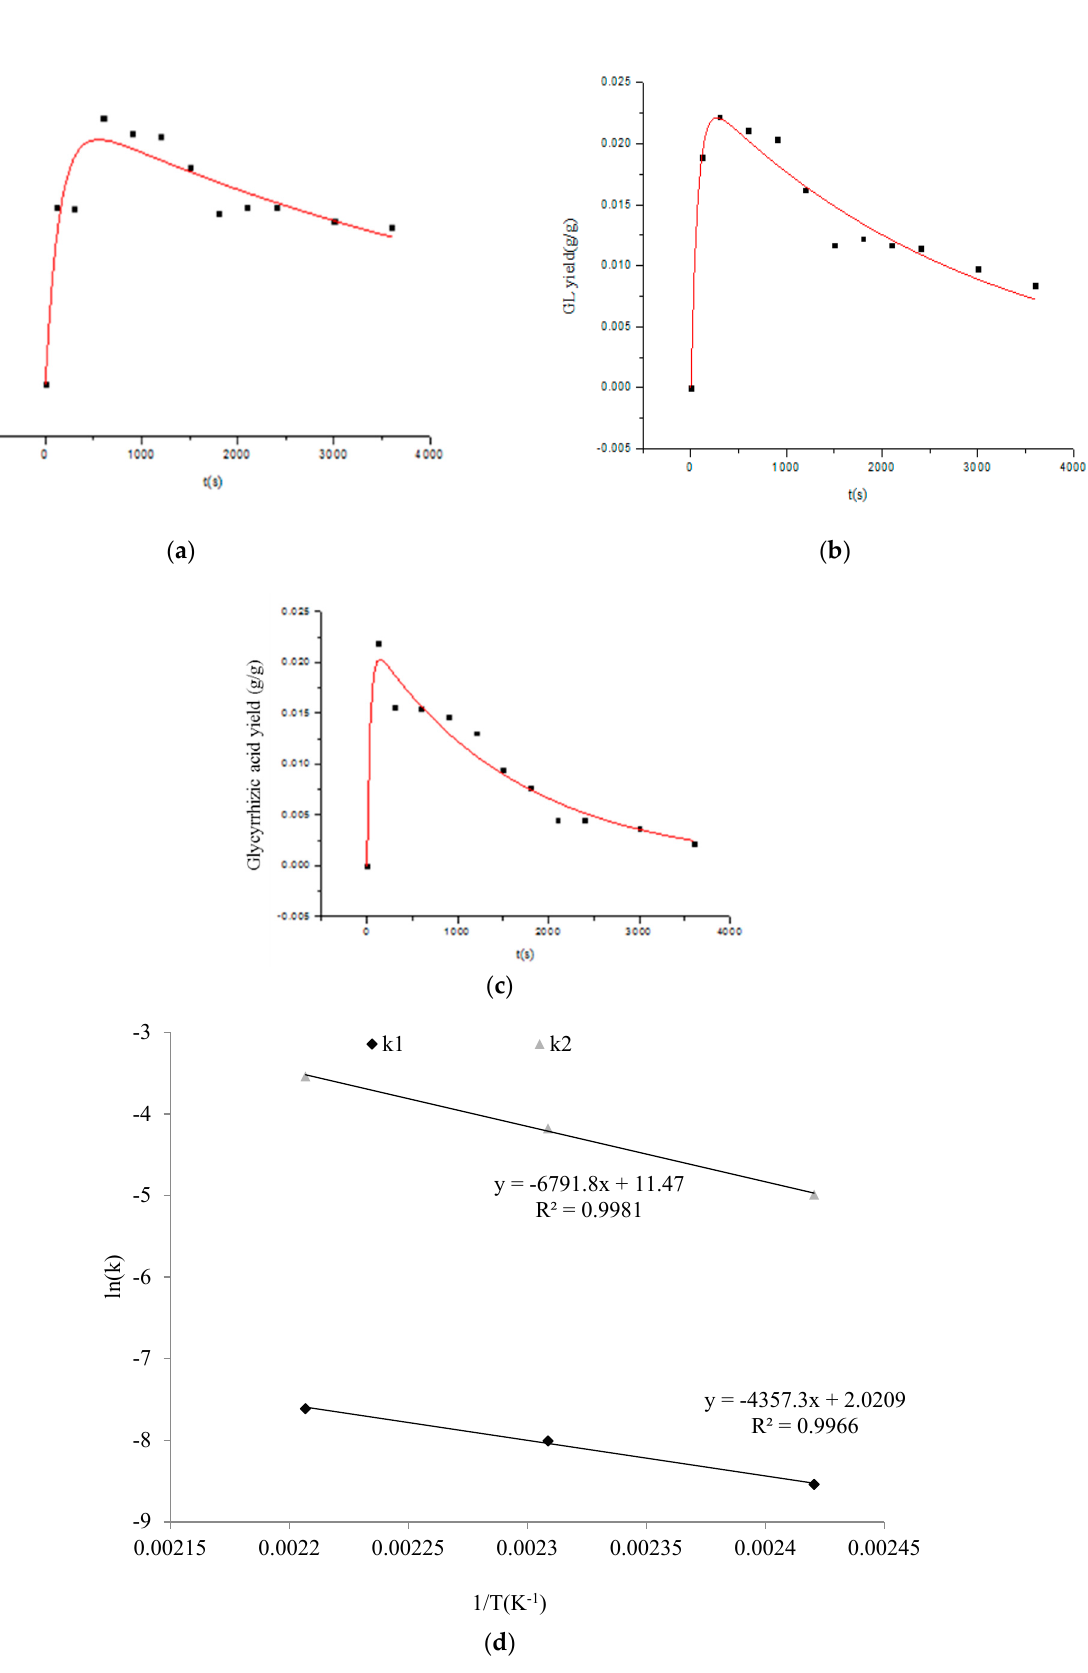
Figure 6. The kinetic parameters at different temperatures, ( a – c ) the fitting curve of the extraction and hydrolytic rate constant at 140 ◦ C, 160 ◦ C, and 180 ◦ C, respectively; ( d ) the Arrhenius